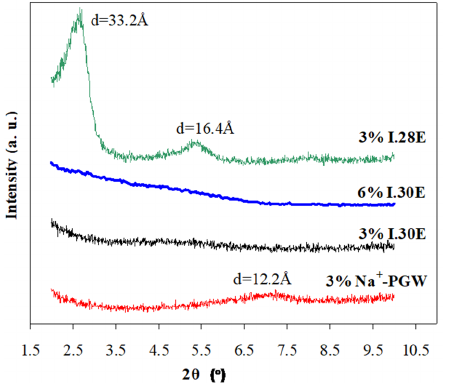
Figure 3. XRD patterns of glassy (EPON 828RS + D ‐ 230 Jeffamine) epoxy—clay nanocomposites with inorganic clay Na + ‐ PGW and the two organoclays I.28E and I.30E; the weight percent of organoclay addition has been estimated on a silicate basis and was 3 and 6 wt %.